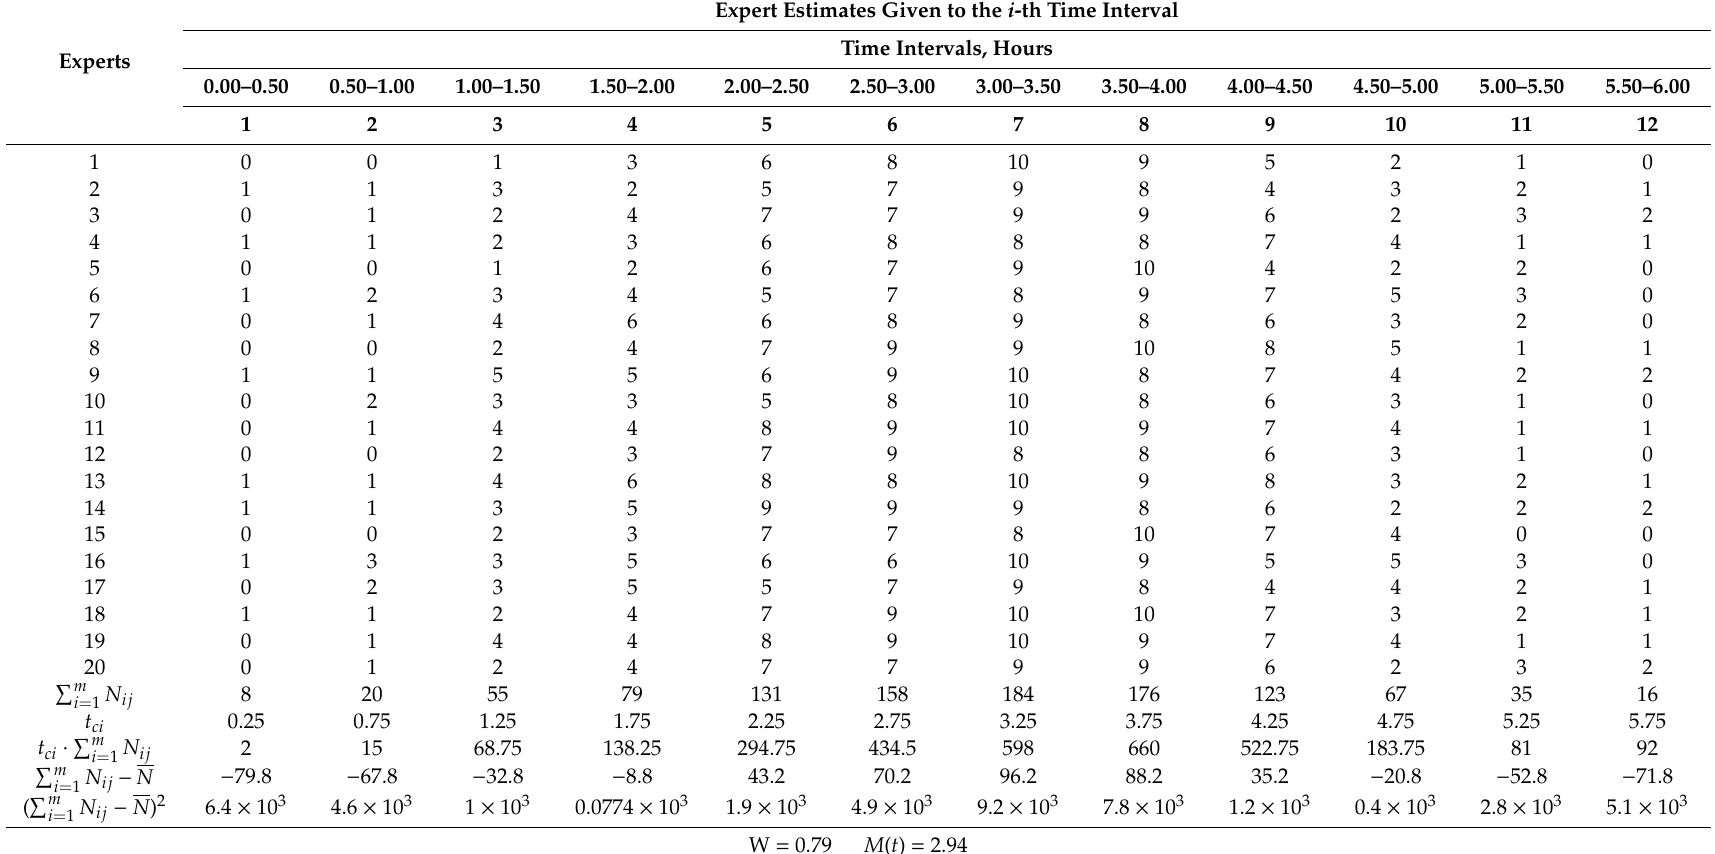
Table 2. The results of the survey of experts to determine the time for recognizing information on